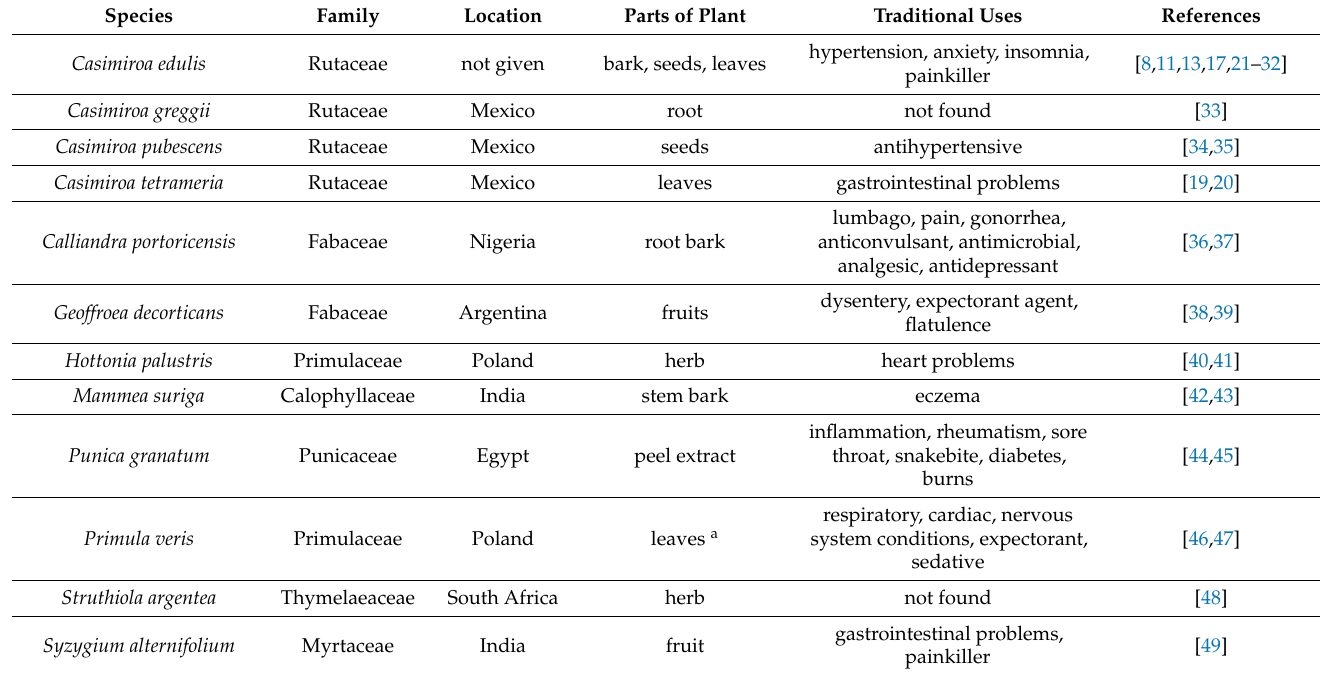
Table 1. Plants containing zapotin and their traditional